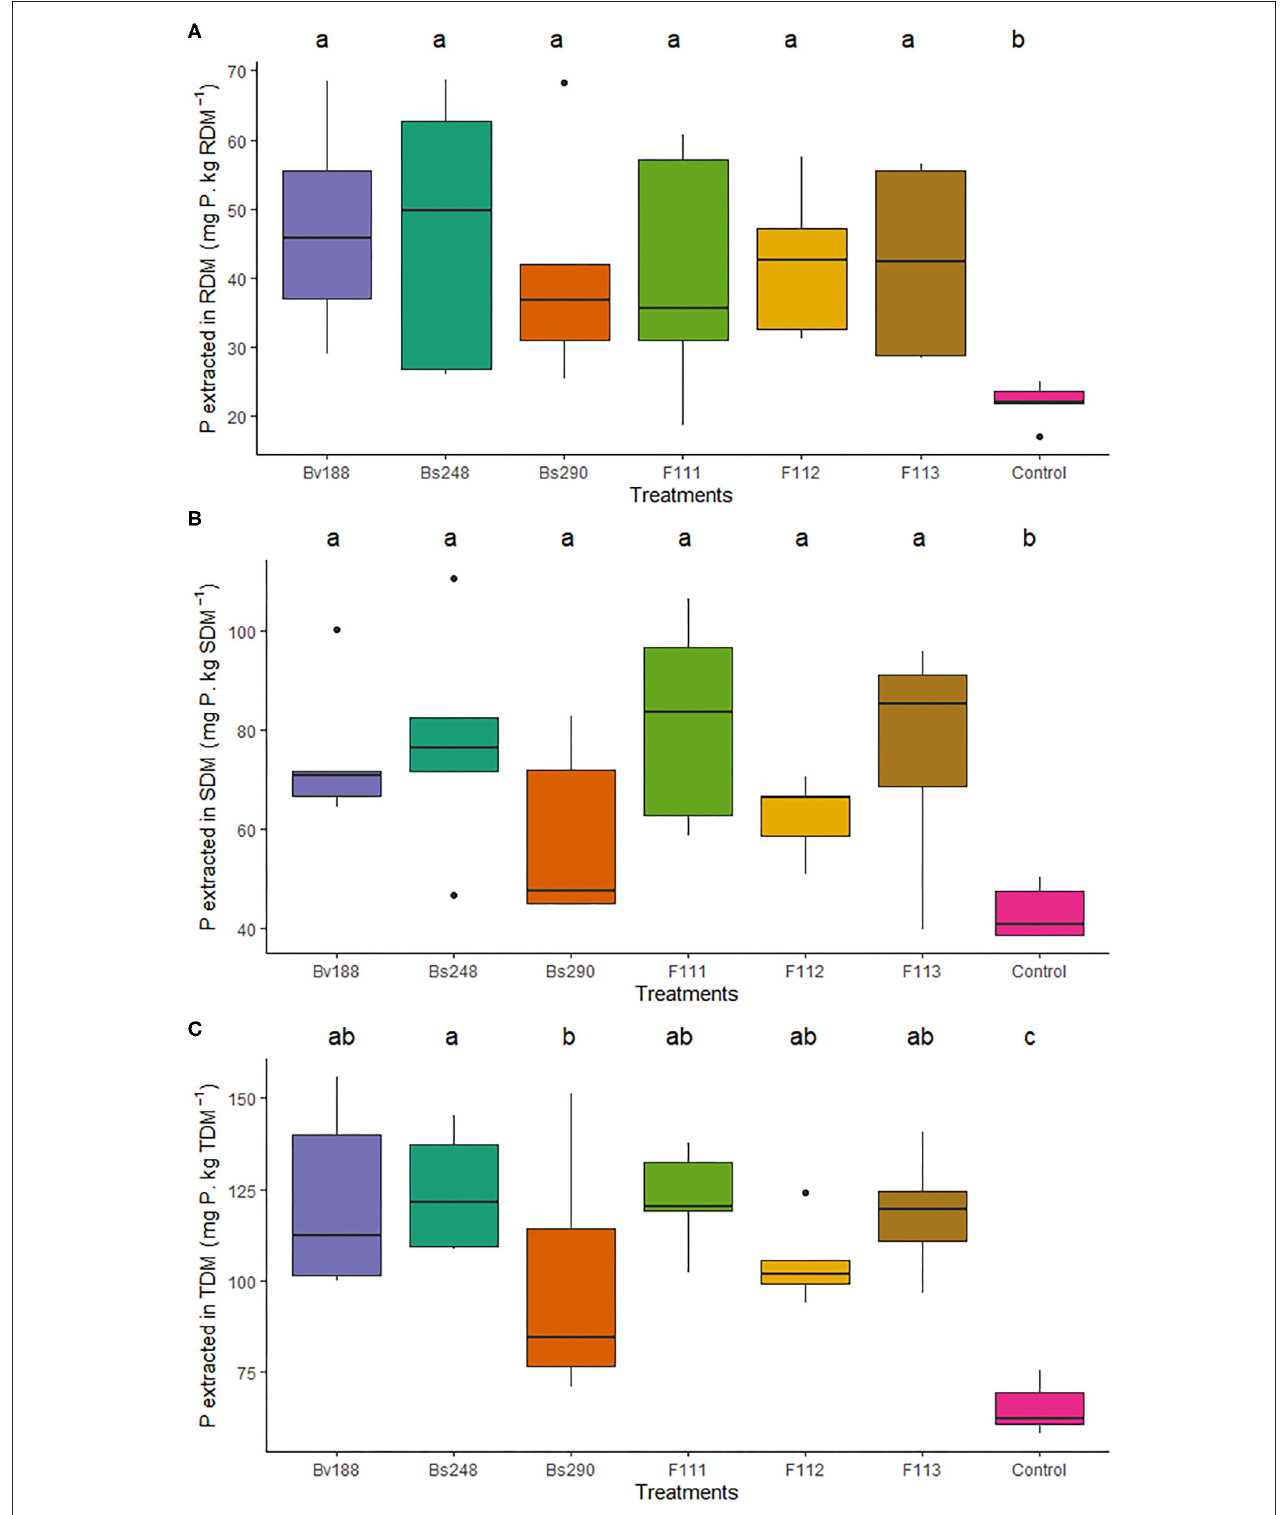
FIGURE 2 | Boxplots (median and quartiles) of P extracted from the roots (A) , shoots (B) , and total dry matter (C) of cotton plants inoculated with the treatments. Different letters in the rows indicate significant differences between means (Duncan’s, p < 0.05). RDM, root dry matter; SDM, shoot dry matter; TDM, total dry matter; Bv188, Bacillus velezensis strain Bv188; Bs248, Bacillus subtilis strain Bs248; Bs290, B. subtilis strain Bs290; F111, Aspergillus brasiliensis ; F112, Aspergillus sydowii ; F113, Aspergillus sp. versicolor section; Control, no